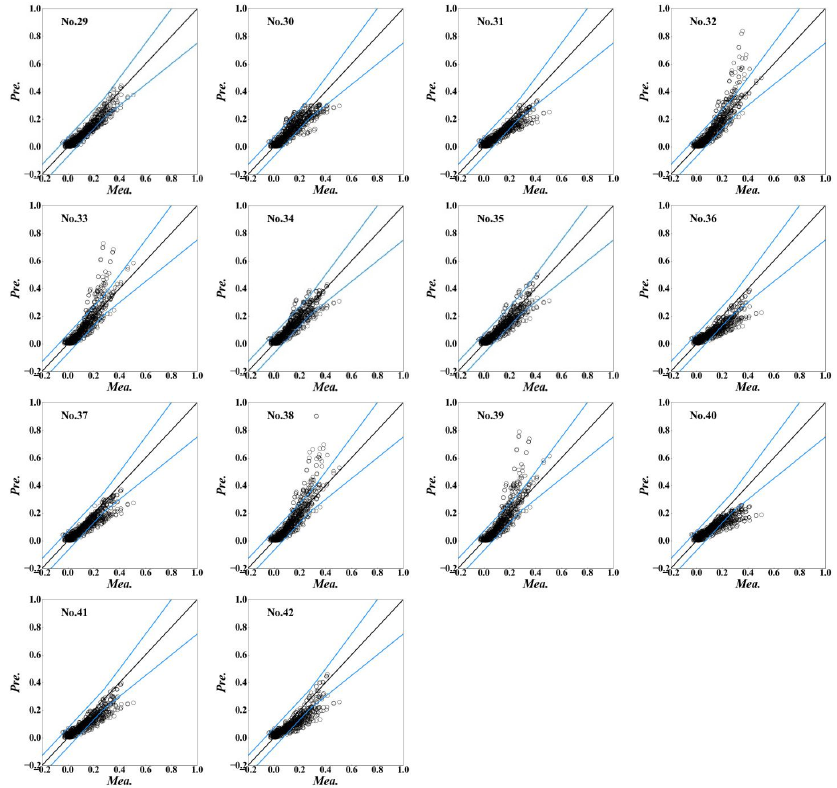
Figure A3. Comparisons of the combined wake models with the Gaussian distribution and the streamwise distribution of BP model.